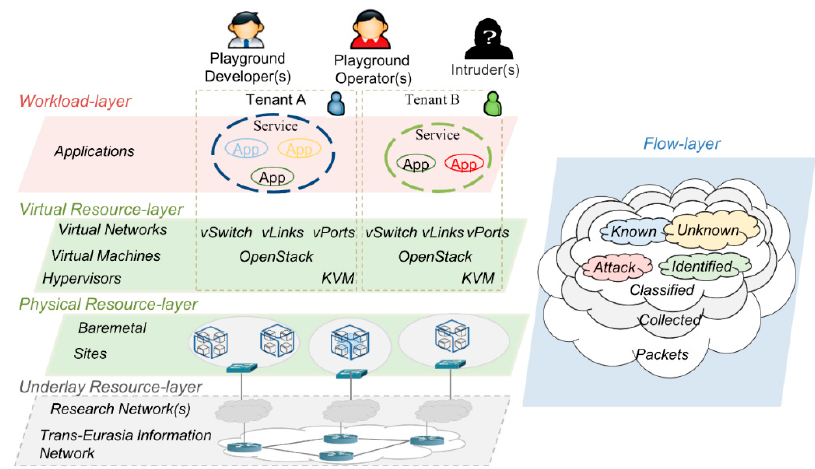
Figure 2. Identified multiple layers of visibilities for SmartX multi-view visibility framework (MVF) that should be integrated through